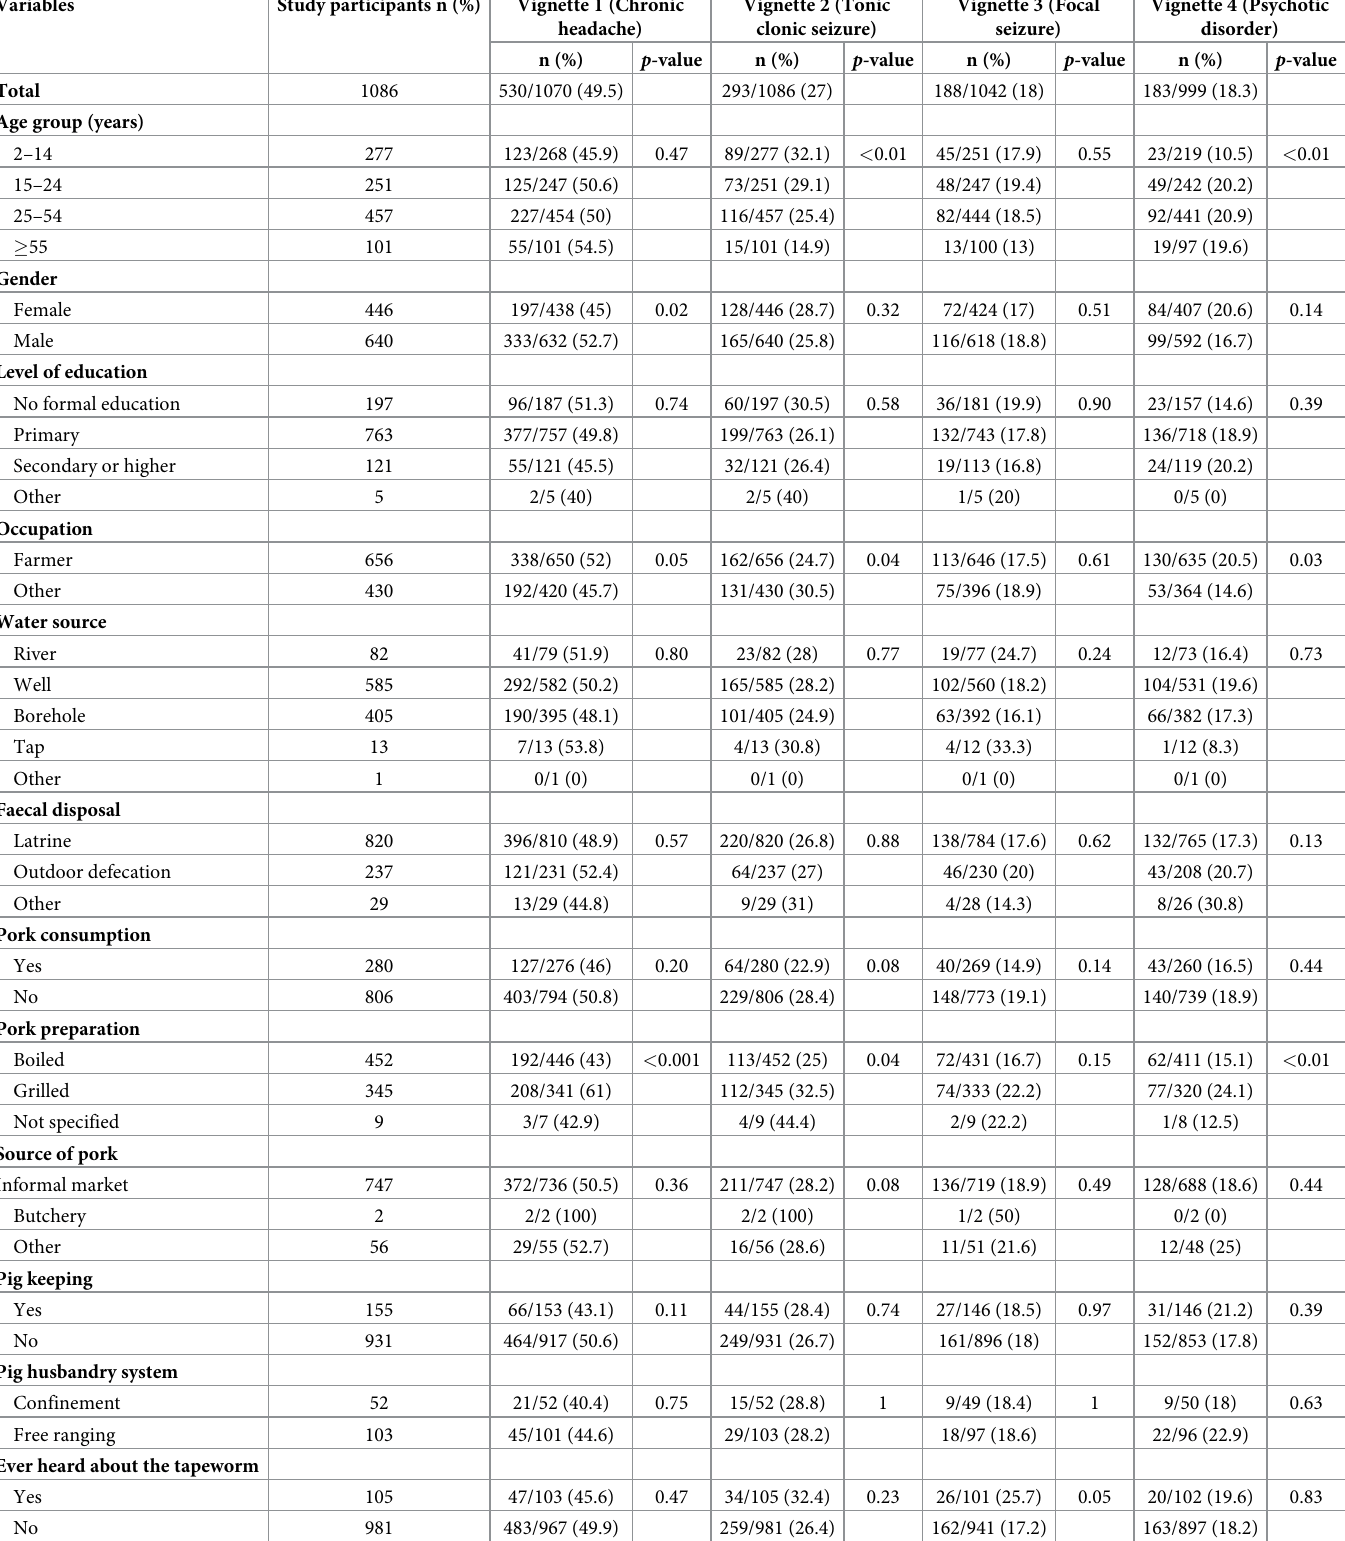
Table 3. Assessment of clinical signs and symptoms related to neuropsychiatric disorders in relation to socio-demographic factors.